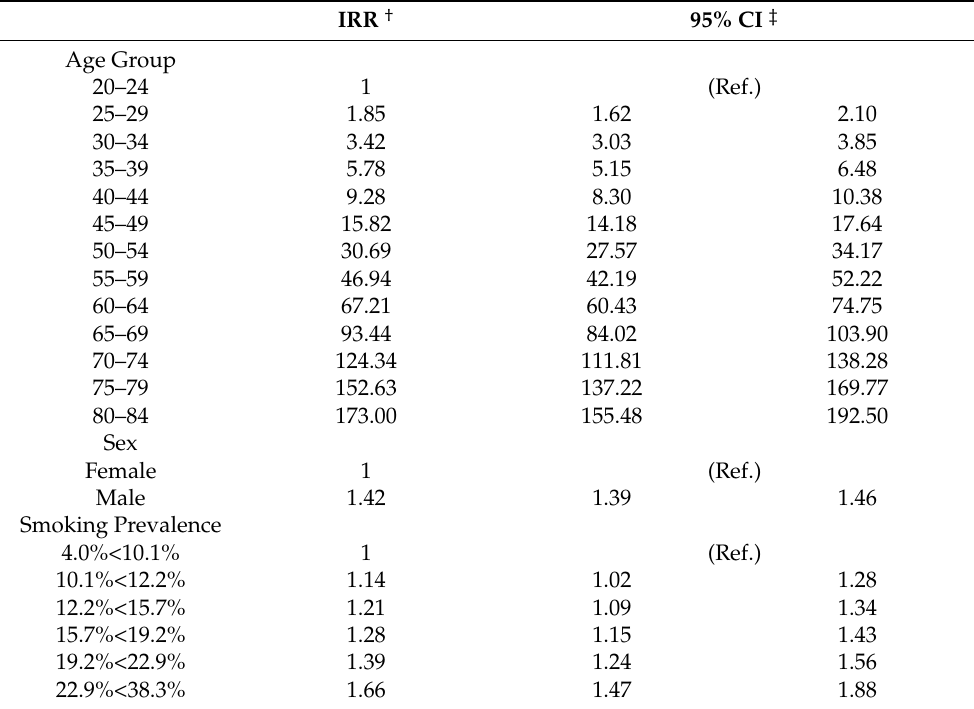
Table 1. Incidence rate ratios for determinants a of 12 smoking-related types of cancer b in the 257 SEER metropolitan counties, 2016—results of a multilevel negative binomial regression